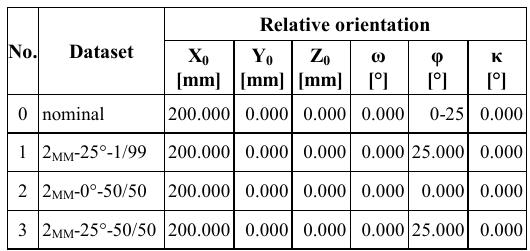
Table 4. Relative orientation as a result of the multimedia bundle adjustment for the most critical